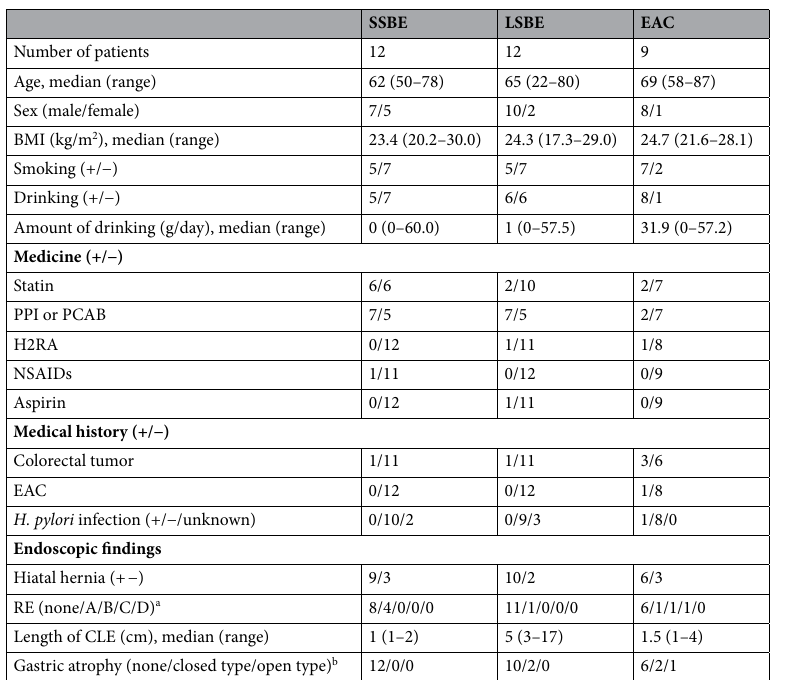
Table 1. Patients’ characteristics. BE Barrett’s esophagus, BMI body mass index, CLE columnar-lined epithelium, EAC esophageal adenocarcinoma, GERD gastroesophageal reflux disease, H2RA H2 receptor antagonist, LSBE long-segment Barrett’s esophagus, NSAIDs nonsteroidal anti-inflammatory drugs, PCAB potassium-competitive acid blocker, PPI proton pump inhibitor, SSBE short-segment Barrett’s esophagus, RE reflux esophagitis. a Reflux esophagitis was graded according to the Los Angeles classification (A–D). b